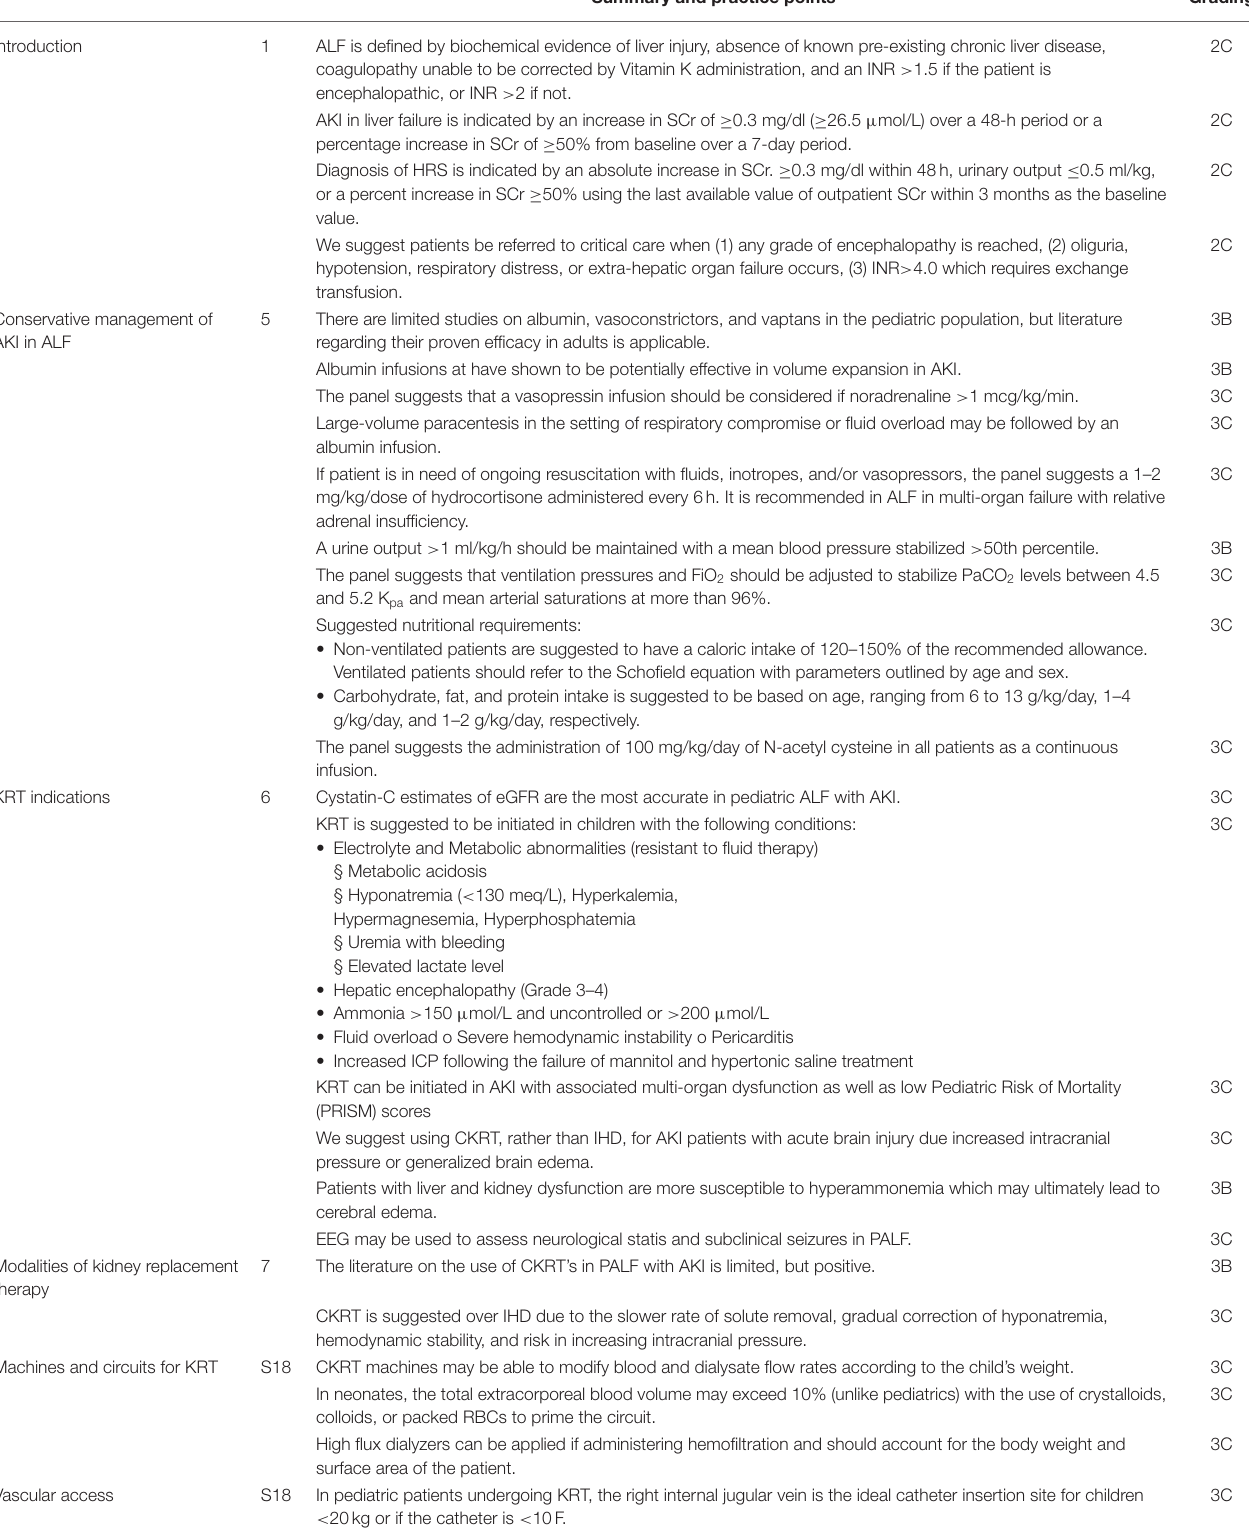
TABLE 1 | Summary and practice